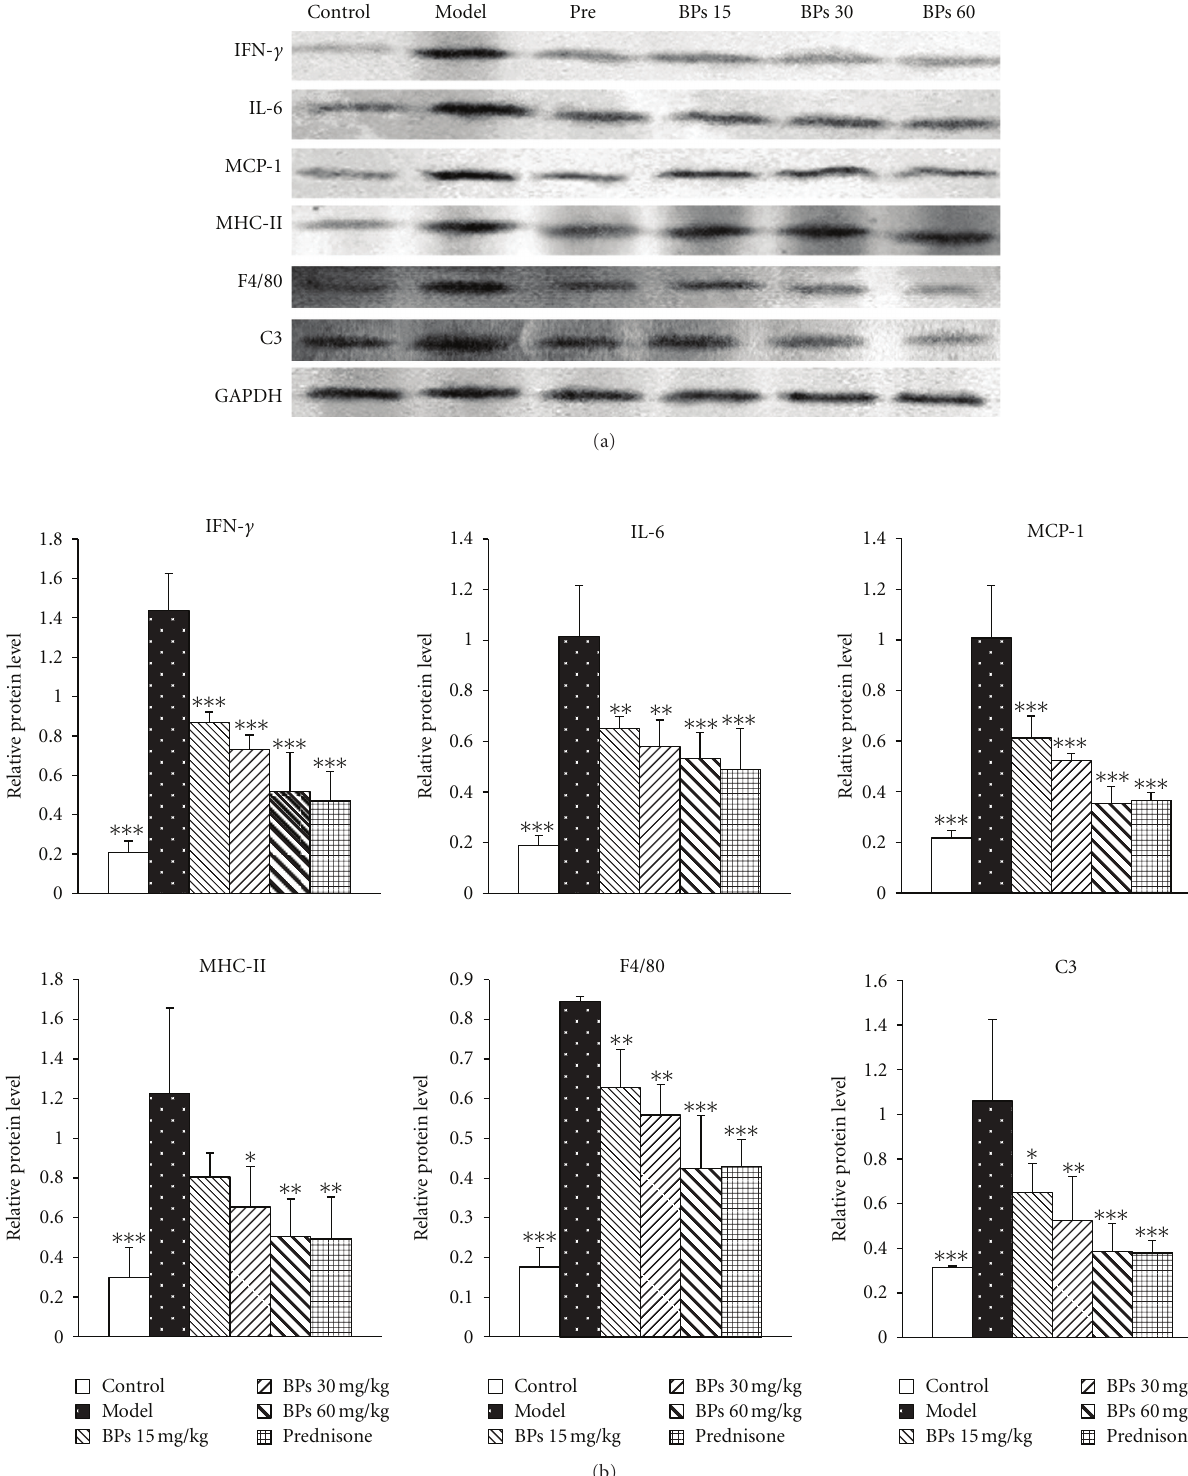
Figure 7: Protein expression of IFN- γ , IL-6, MCP-1, MHC-II, F4/80, and C3 in the kidneys of MRL/lpr mice. (a) Renal expressions of IFN- γ , IL-6, MCP-1, MHC-II, F4/80, and C3 were examined by Western blot analysis. The presented blot was a representative of those obtained from three mices. GAPDH was used as loading control. (b) Results of quantitative analysis were expressed as means ± S.D. ratio of IFN- γ , IL-6, MCP-1, MHC-II, F4/80, and C3 to GADPH ( n = 3). ∗ P < 0 . 05, ∗∗ P < 0 . 01, ∗∗∗ P < 0 . 001 compared with vehicle-treated model group, tested by ANOVA and Fisher’s